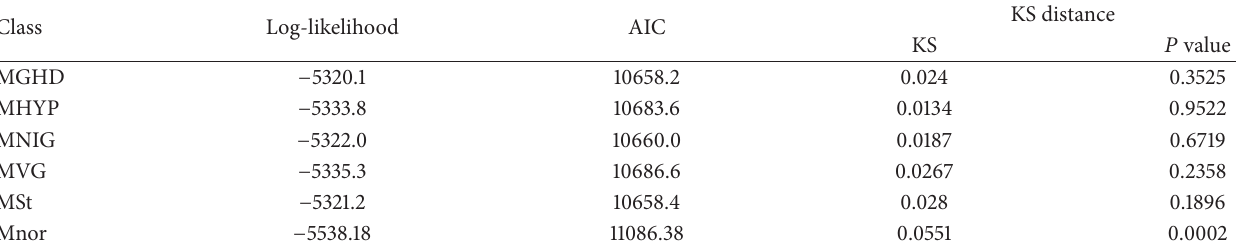
Table 6: Log-likelihood, AIC, and KS